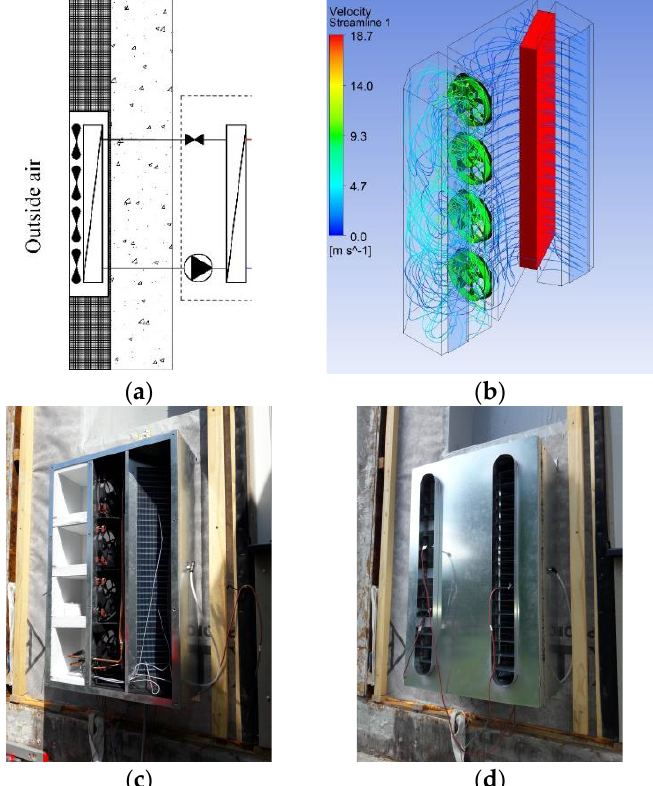
Figure 20. Façade integrated outdoor unit of an exhaust to supply air heat pump with external com- pressor ( a ), ( b ) airflow streamlines (for velocity) inside the mock-up from CFD simulations with two radial fans, picture of the functional model of the outdoor unit (( c ) with open casing and ( d ) with closed casing) resulting from the CFD analysis realised within the Austrian (FFG) research project Salüh! (see also Ref. [11]).